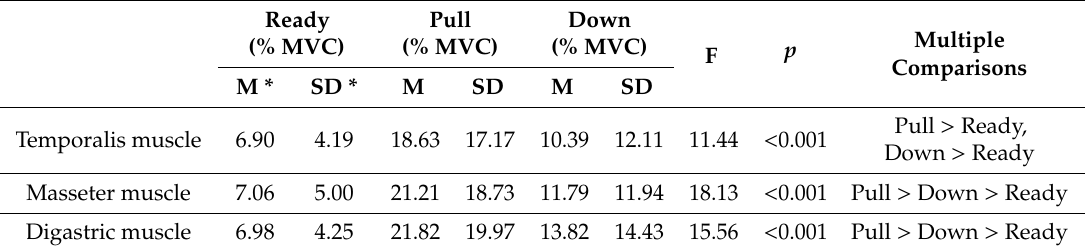
Table 2. Muscle activities during the steps of the deadlift (Ready, Pull,